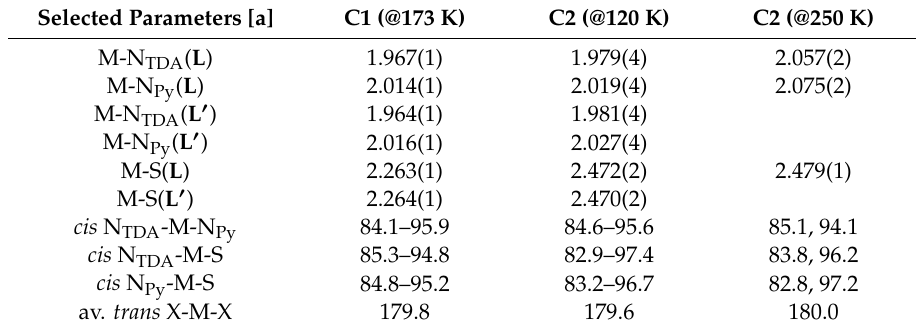
Table 1. Selected bond lengths [Å ] and bond angles [°] for the compounds [Fe II ( L ) 2 ](ClO 4 ) 2 ( C1 ) and [Co II ( L ) 2 ](ClO 4 ) 2 ( C2 ).